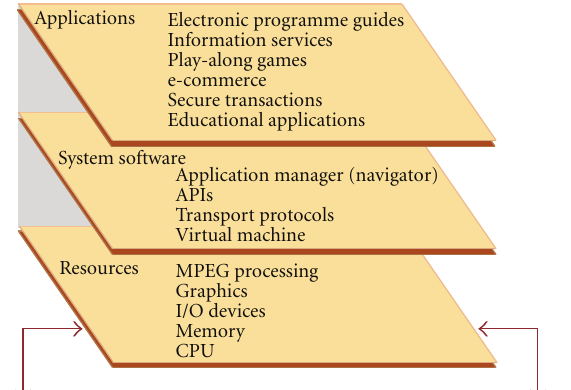
Figure 4: MHP Layer Architecture